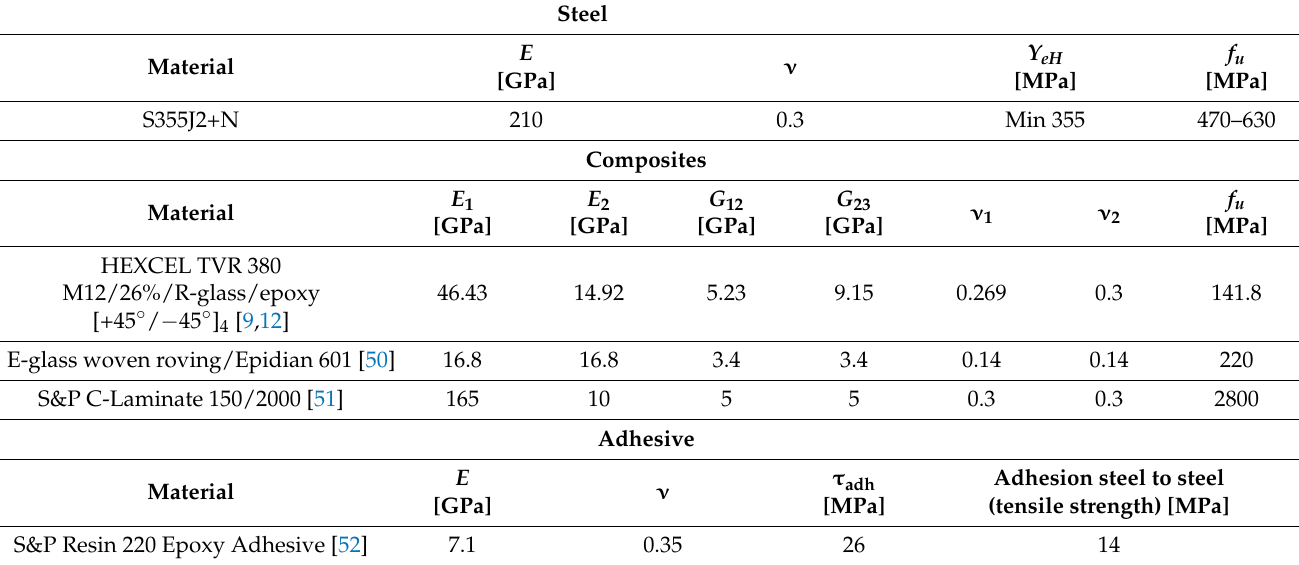
Table 2. Mechanical material